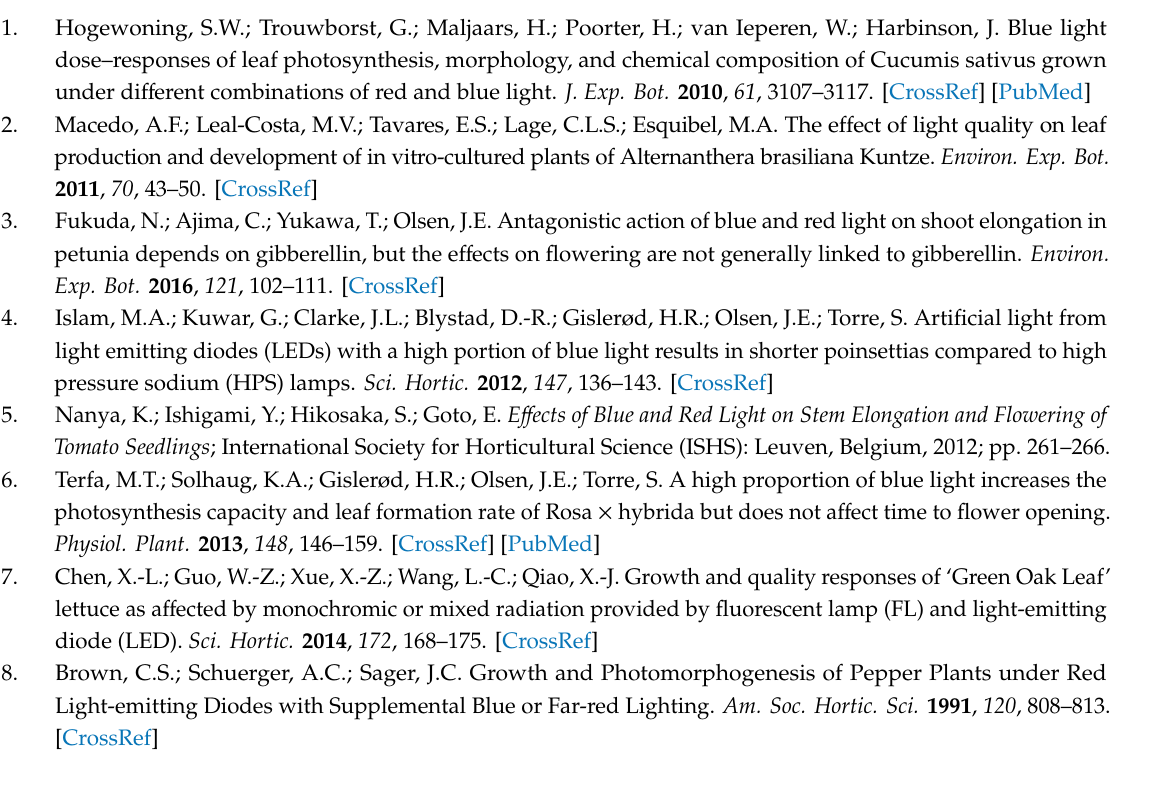
Table S1: Transcript classification statistics, Table S2: Illumina data filtering statistics, Table S3: Non-redundant isoform statistics, Table S4: RNA Sequence map statistics, Figure S5: GO annotation, Figure S6: KEGG annotation, Figure S7: eggNOG annotation, Table S8: Swissprot annotation, Table S9: The results of annotation in five di ff erent databases, Figure S10: NR_species_distribution, Table S11: GO enrichment analyses for DEGs between di ff erent light qualities, Table S12: Primers used for qRT-PCR validation, Figure S13: Influences of plant circadian rhythm pathway under WL vs. BL in C. oleifera leaves, Figure S14: Influences of plant hormone signal transduction pathway under WL vs. BL in C. oleifera